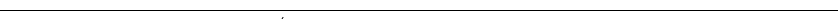
Fig. 6 SynGAP1 accumulation blocks Ras/ERK signaling at the post-synapse in tau − / − mice. a Western blotting of brain extracts; PTZ induced transient ERK phosphorylation 10 min after administration in tau +/+ but not tau − / − mice, b as con fi rmed by quanti fi cation of independent blots (** p < 0.01; N = 6; one-way ANOVA (Tukey post hoc)). c Primary tau +/+ but not tau − / − neurons showed ERK phosphorylation when challenged with 10 and 25 µ M NMDA, d as con fi rmed by quanti fi cation of independent blots (* p < 0.05; ** p < 0.01; *** p < 0.001; N = 3; one-way ANOVA (Tukey post hoc)). e Primary tau +/+ neurons showed ERK phosphorylation when treated with bicuculline (BIC), forskolin (FOR) and KCl. In contrast, primary tau − / − neurons showed only increased ERK phosphorylation upon treatment with FOR, though to a lower degree. f Quanti fi cation of independent blots con fi rmed BIC-, FOR- and KCl- induced ERK phosphorylation in tau +/+ neurons, while only FOR signi fi cantly activated ERK in tau − / − cells (* p < 0.05; *** p < 0.001; **** p < 0.0001; N = 6; one-way ANOVA (Tukey post hoc)). g BIC treatment of primary neurons resulted in upregulation of Arc, Fos and Junb mRNA levels in tau +/+ , but little to none in tau − / − cells (** p < 0.01; *** p < 0.001; N = 6; Student ’ s t -test). h Activated Ras (Ras-GTP) was pulled down from KCl treated tau +/+ , but not tau − / − brain slices. Total Ras levels, however, were comparable tau − / − and tau +/+ mice. Concomitant ERK activation was only seen in KCl treated tau +/+ slices. i Quanti fi cation of independent blots con fi rmed that Ras activation occurred only in tau +/+ mice (*** p < 0.001; N = 6; one-way ANOVA (Tukey post hoc)). j Confocal imaging of primary neurons co-stained with SynGAP1 ( green ) and PSD-95 ( red ) showed more intensive labeling of spines for SynGAP1 that co-localized with PSD-95 in tau − / − than in tau +/+ neurons. k Both, immuno fl uorescence intensity and cluster size of SynGAP1 in spines were signi fi cantly increased in tau − / − compared to tau +/+ neurons (** p < 0.01; *** p < 0.001; N = 5; Student ’ s t -test). l Immunoprecipitation (IP) with a SynGAP1-speci fi c antibody co-puri fi ed 3.8-fold more PSD-95 from tau − / − brain extracts than from tau +/+ lysates. Control (ctr) precipitations were done without primary antibodies. Load represents brain extracts used for immunoprecipitation. M, marker. m Quanti fi cation of 6 independent experiments showed a signi fi cant increase in SynGAP1/PSD-95 interaction in tau − / − compared to tau +/+ mice (** p < 0.01; N = 6; Student ’ s t -test). n SynGAP1 interacts with tau in brain extracts from wild-type mice, as revealed by co-IP using a tau-speci fi c antibodies (tau5). Control (ctr) precipitations were done without primary antibodies. M, marker lanes. o SynGAP1 and tau are in a complex within dendritic spines, as determined by a < 40 nm proximity ligation assay (SynGAP1:tau; red ) using SynGAP1- and tau-speci fi c antibodies. Dendritic shafts were counter-stained with β 3-tubulin ( green ). p IP of FLAG-PSD95 co-precipitated SynGAP1 in the absence but not in the presence of tau from transiently transfected cells (load) ( N = 3). All error bars are